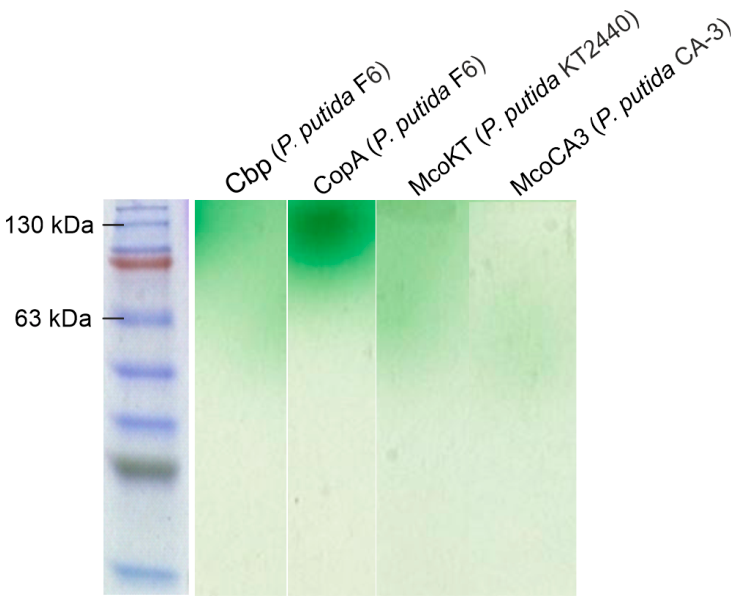
Figure 3. Zymography assay of purified laccases from Pseudomonas species using native PAGE analysis. The first lane—BlueStar prestained protein marker (Nippon genetics). Lanes from left to right: Cbp ( P. putida F6), CopA ( P. putida F6), McoKT ( P. putida KT2440), and McoCA3 ( P. putida CA-3).